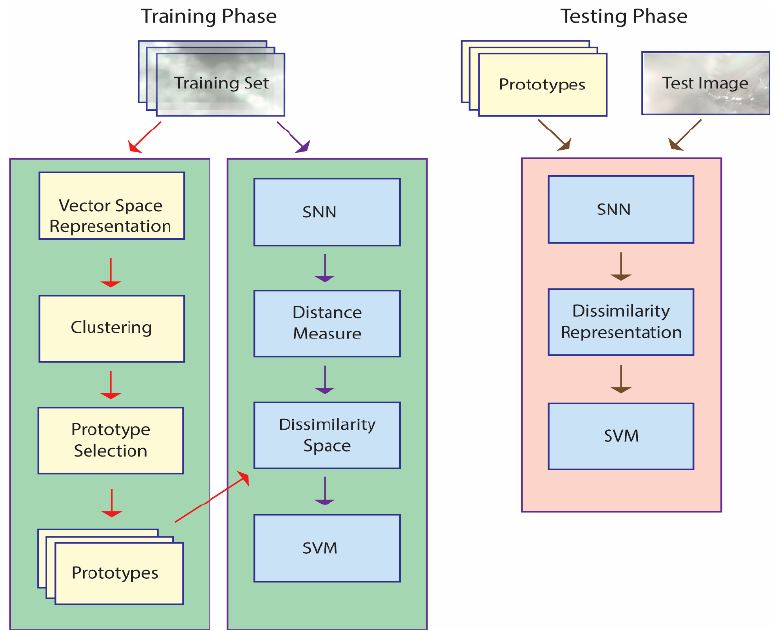
Figure 1. A basic outline of the proposed approach. Note: in the training phase, prototype selection is performed, and an SNN is trained to define a dissimilarity measure; in the testing phase, each unknown pattern is represented by its distances to the prototypes and classified accordingly.